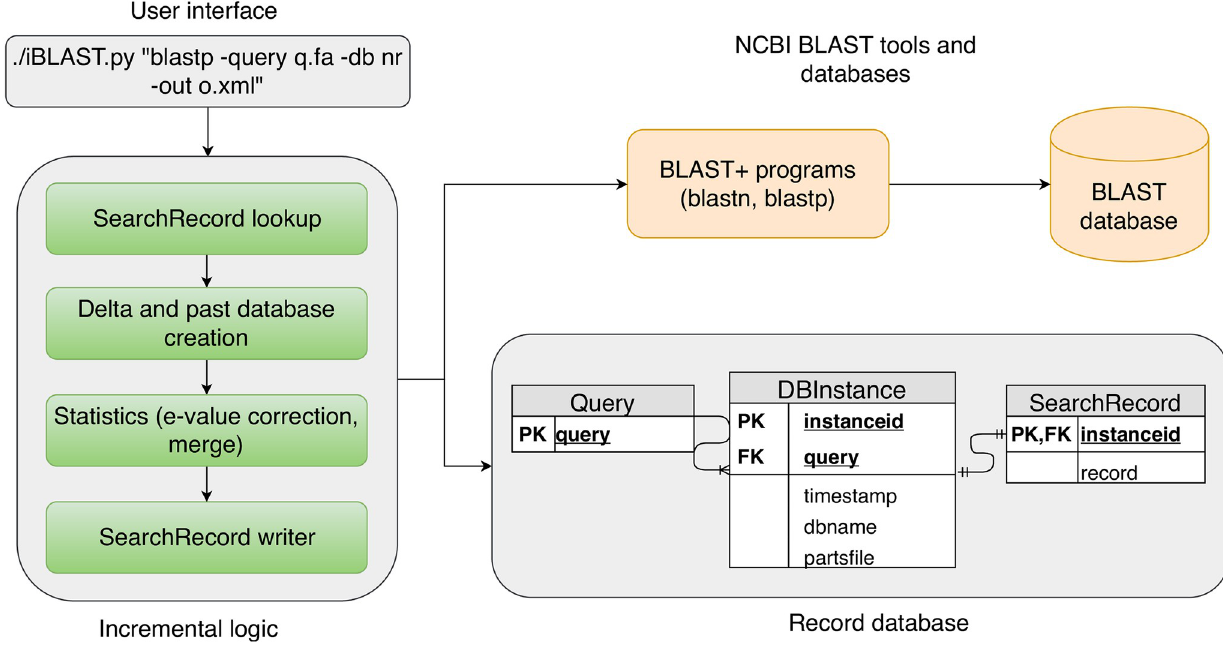
Fig 2. Software stack of iBLAST. The user can initiate a search using the user interface. The search parameters are then passed to the “Incremental logic” module. After performing an incremental search, this module’s back-end corrects the e-value statistics and merges the result. The “Incremental logic” module looks into an external lightweight database module called the ( Record database ) to decide whether and how to perform the incremental search. For the actual search and delta database creation, we use NCBI BLAST tools such as blastdbcmd, blastdbalias, blastp, and